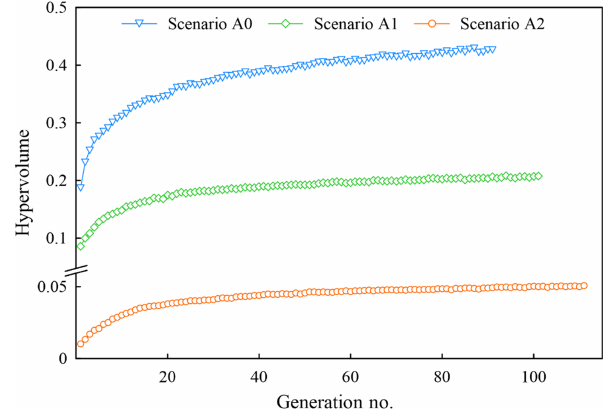
Figure 12. Evolution of the hypervolume metric over the generation number for scenarios A0, A1, and A2.